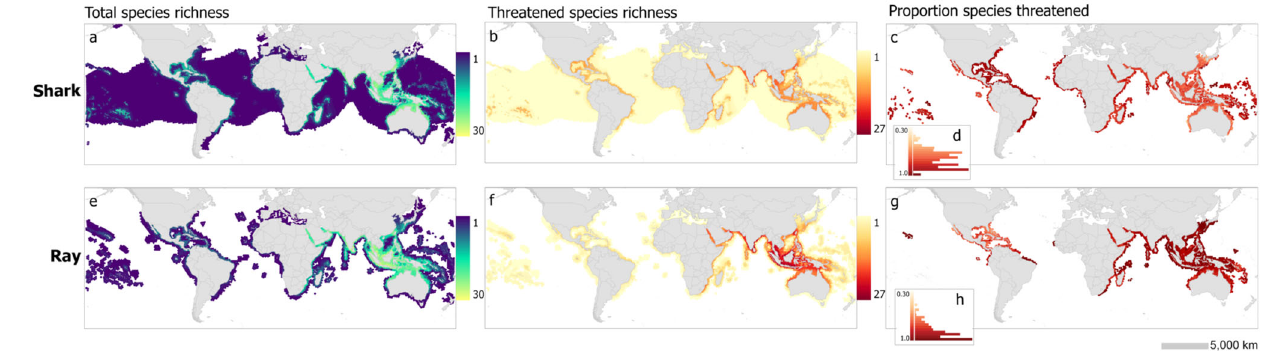
Fig. 4| Globalsharkandrayspeciesrichness,threat,andproportionthreatened by group. a , e species richness by group. b , f number of threatened species by group. c , g threatened species as a proportion of total richness (for cells with